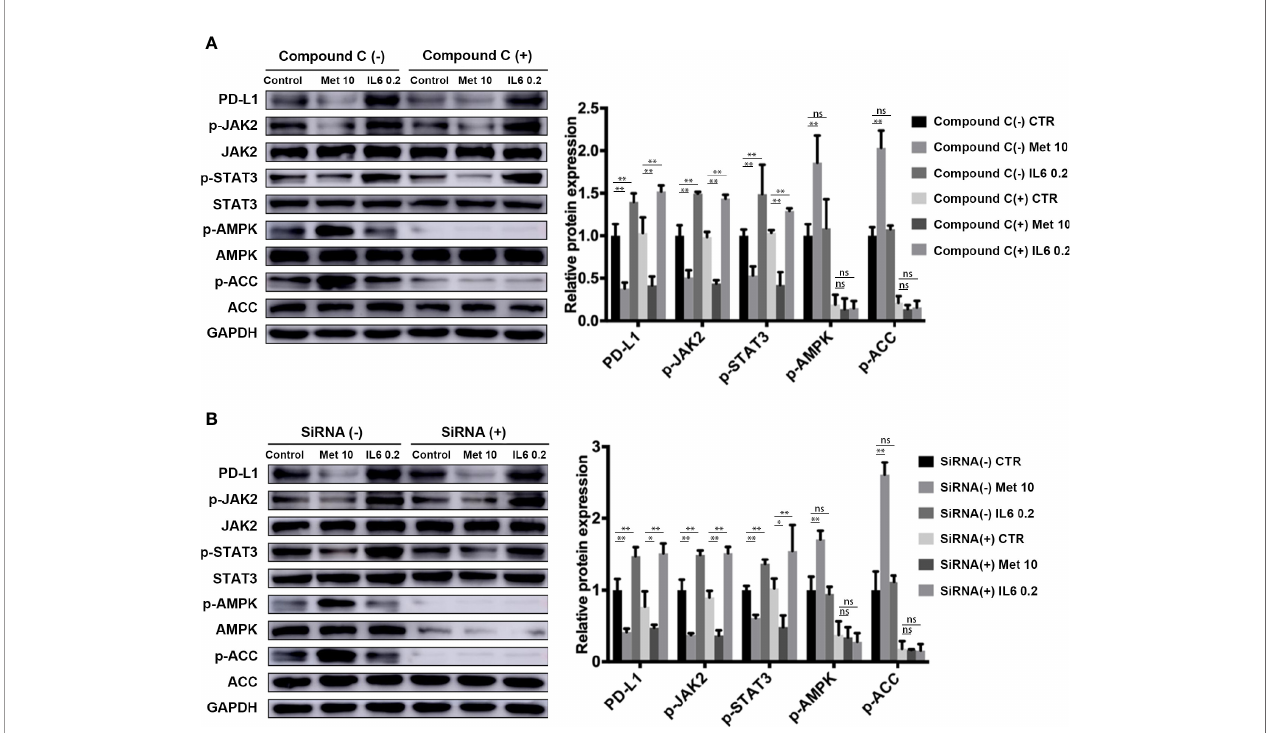
FIGURE 4 | Metformin attenuates IL-6 downstream signaling through an AMPK-independent pathway. (A) KYSE-450 cells were pretreated with the AMPK inhibitor compound C (5 m M) for 4 h. (B) Negative control siRNA and AMPK a 1/2 siRNA (80 nM) were transfected into KYSE-450 cells for 48 h. Cells were treated with metformin (10 mM) or IL-6 (0.2 ng/mL) for 36 h, independently. Western blot analysis and quanti fi cation of p-Jak2, Jak2, p-Stat3, Stat3, p-AMPK, AMPK, p-ACC, ACC and GAPDH were performed. Data are mean ± SEM. Kruskal – Wallis ANOVA combined with post- hoc Dunn ’ s multiple comparison test (two tailed) was performed. *p < 0.05, **p < 0.01; ns, no signi fi